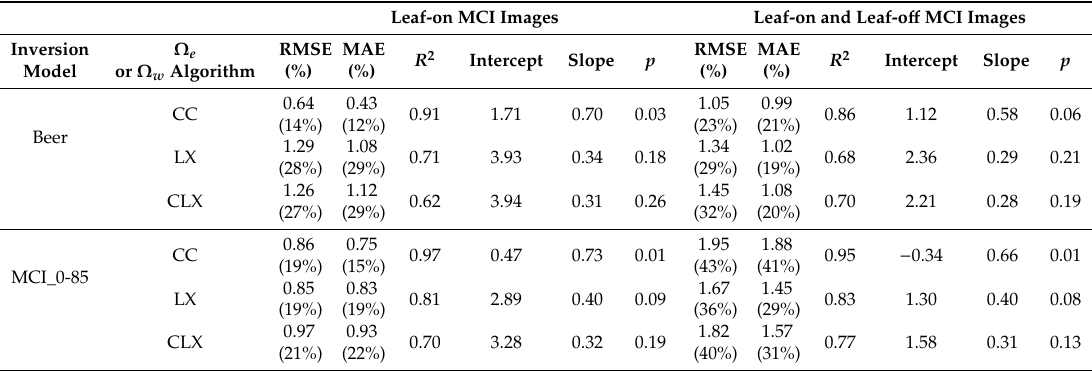
Table 7. Correlation statistics between the litter collection LAI and LAI derived from the leaf-on or both the leaf-on and leaf-o ff MCI images using the three canopy element or woody components clumping index ( Ω e or Ω w ) algorithms and the inversion models in the five plots (two-tailed Student’s t -test with 95% confidence level). The RMSE and MAE are expressed in LAI units (m 2 / m 2 ). Leaf-on MCI Images Leaf-on and Leaf-o ff MCI